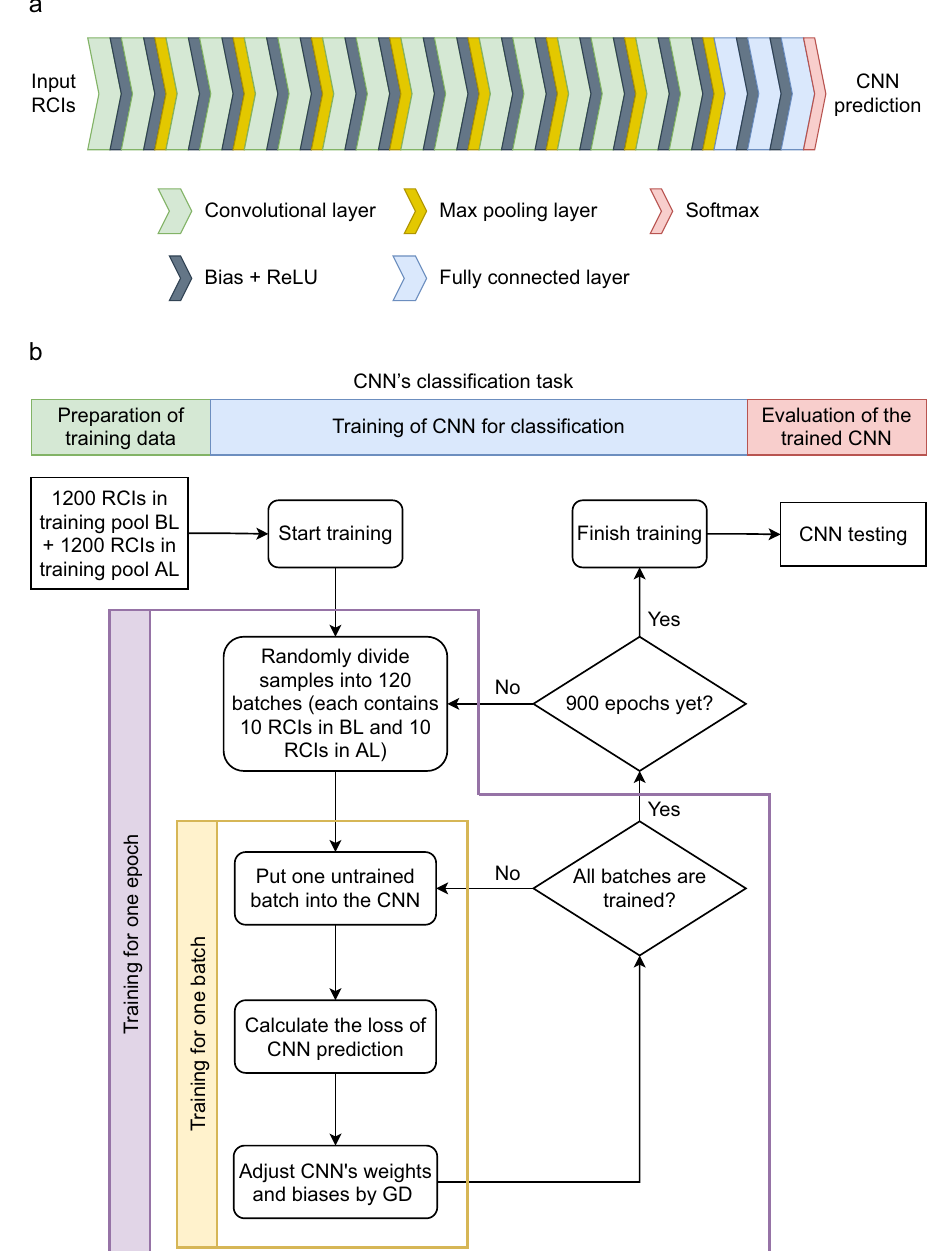
Figure 9. CNN. ( a ) The CNN constructed of convolutional layers, max pooling layers, and fully connected layers returns a prediction vector indicating the classification of the input RCI belonging to “after” learning (AL) or “before” learning (BL). ( b ) The CNN’s classification task is composed of the preparation of training data, the training of CNN for classification, and the evaluation of the trained CNN. Training CNN for a batch of RICs requires the calculation of GD of the loss of predicted results, which in turn adjusts CNN’s weights and biases to improve the performance of CNN. After one epoch of training throughout all batches of RCIs, we redistribute RCIs randomly into batches and initiate the next generation of batch training. We stop training CNN after 900 epochs and then test its classification